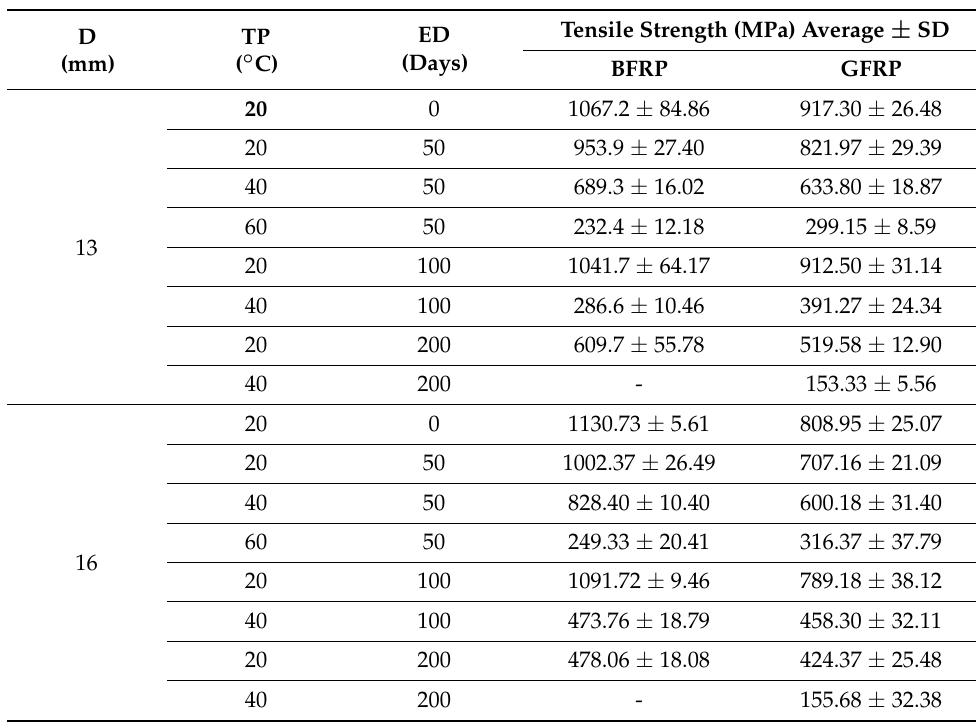
Table 2. Tensile test results of BFRP and